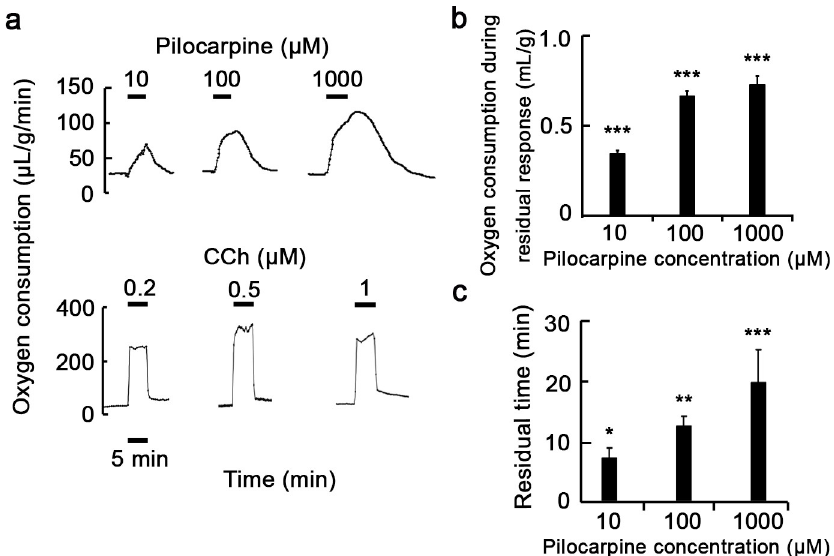
Fig 5. Pilocarpine-induced residual oxygen consumption in perfused submandibular glands of rats. Submandibular glands were stimulated with 1–1000 μ M pilocarpine or 0.2–1 μ M carbachol (CCh) for 5 min. Profiles of oxygen consumption induced by pilocarpine or carbachol (a). Stimulating duration is indicated as black bars. Results are representative of three independent experiments. Residual oxygen consumption (b) and residual time (c) induced by various concentrations of pilocarpine. Data are means ± S.E. of three independent experiments. � , P < 0.05, �� , P < 0.01 and ��� , P < 0.001 compared with unstimulated glands.